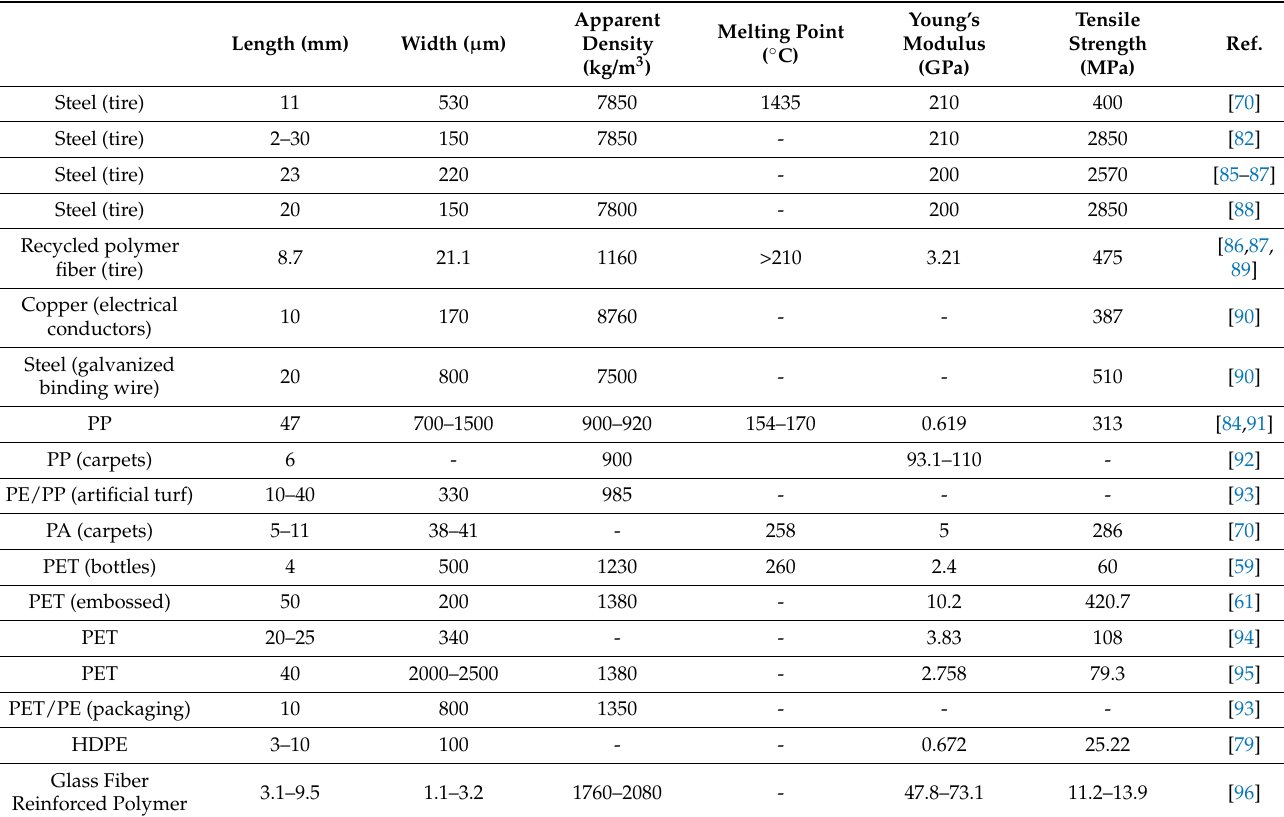
Table 1. Properties of recycled fibers used in hybrid